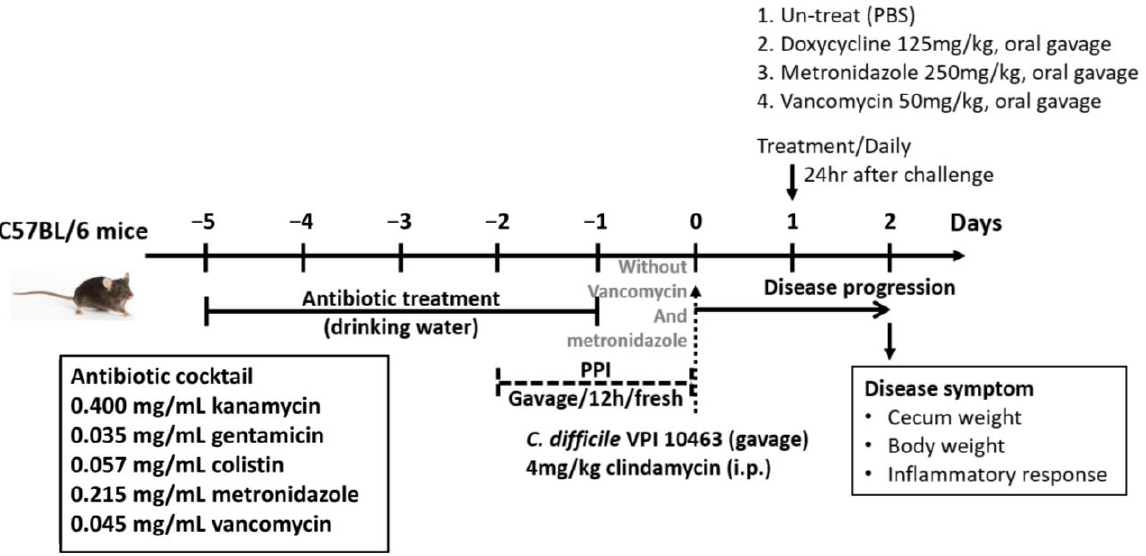
Figure 1. A protocol of oral doxycycline, metronidazole, or vancomycin therapy in Clostridioides difficile -infected mice.